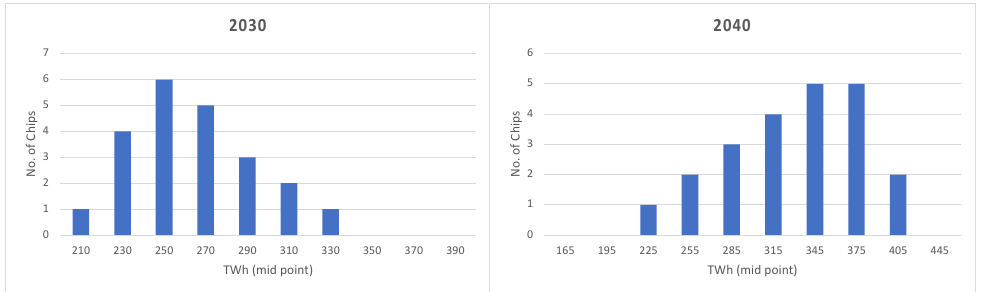
Figure 4. Histograms collectively created by the participants for the RIO phase.